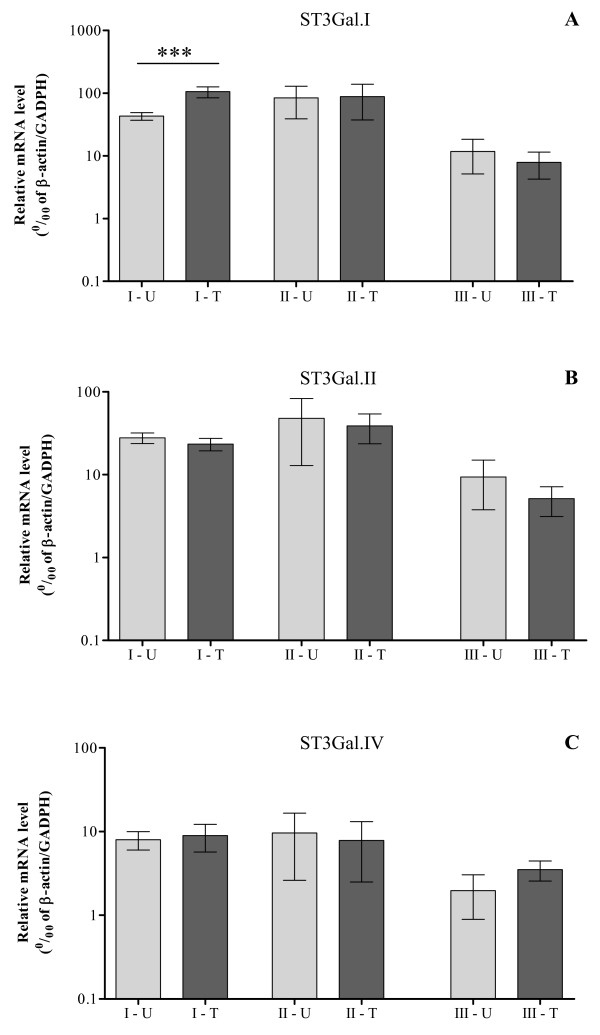
Bladder cancer tissue has increased expression of ST3Gal.I. The relative mRNA levels of ST3Gal.I (A), ST3Gal.II (B) and ST3Gal.IV (C) genes were analyzed by Real Time RT-PCR as described in the Methods section, in bladder tumor tissue (T) and corresponding normal urothelium (U) from patients with nonmuscle-invasive (I), with invasive (II) and with non malignant bladder tumors (III). Values infer the number of mRNA molecules of a certain gene per 1000 molecules of the average of the endogenous controls (β-actin and GAPDH). ST3Gal.I expression is significantly increased in tissue of nonmuscle-invasive bladder cancer (I), compared with the corresponding urothelium (p < 0.001).